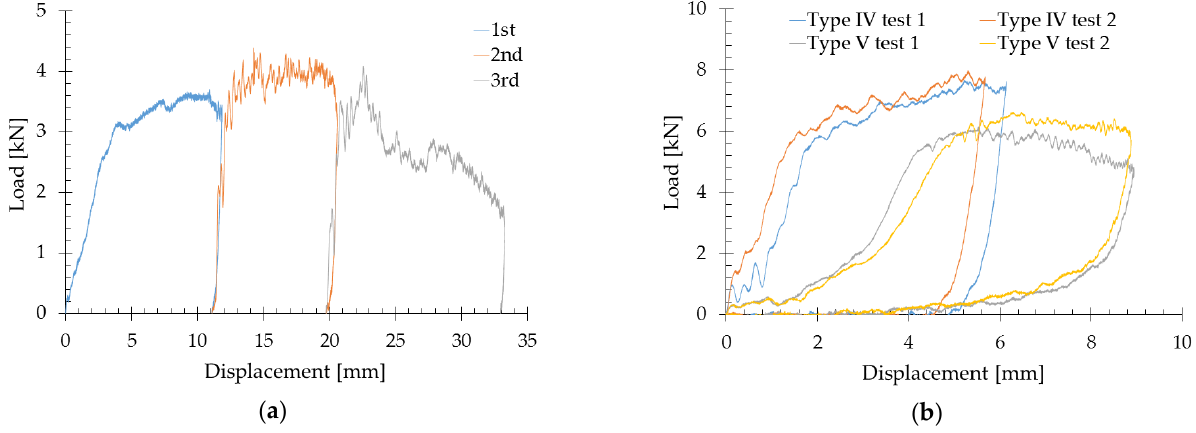
Figure 7. Load–displacement curves at impact energy equal to 35 J. ( a ) First impact tests and ( b ) second impact tests.